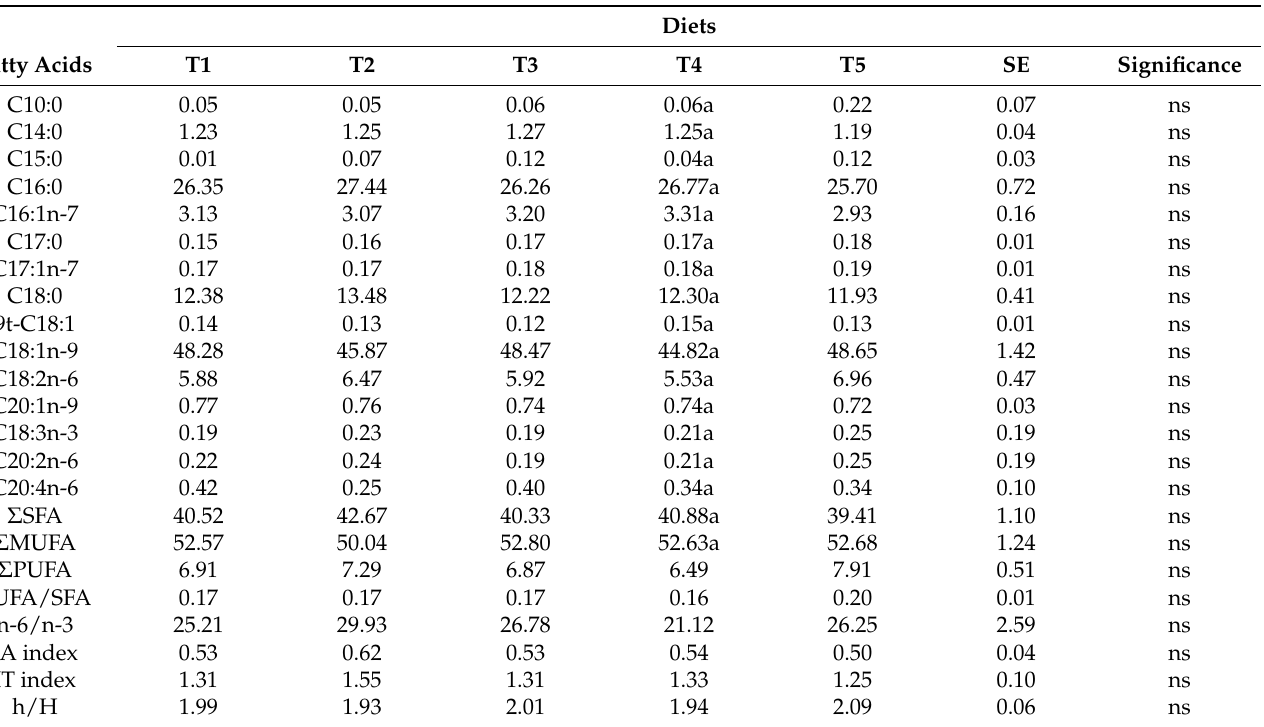
Table 5. Fatty acid profile of intramuscular fat of the Longissimus thoracis et lumborum muscle from the B í saro pig breed. Effect of treatment with olive